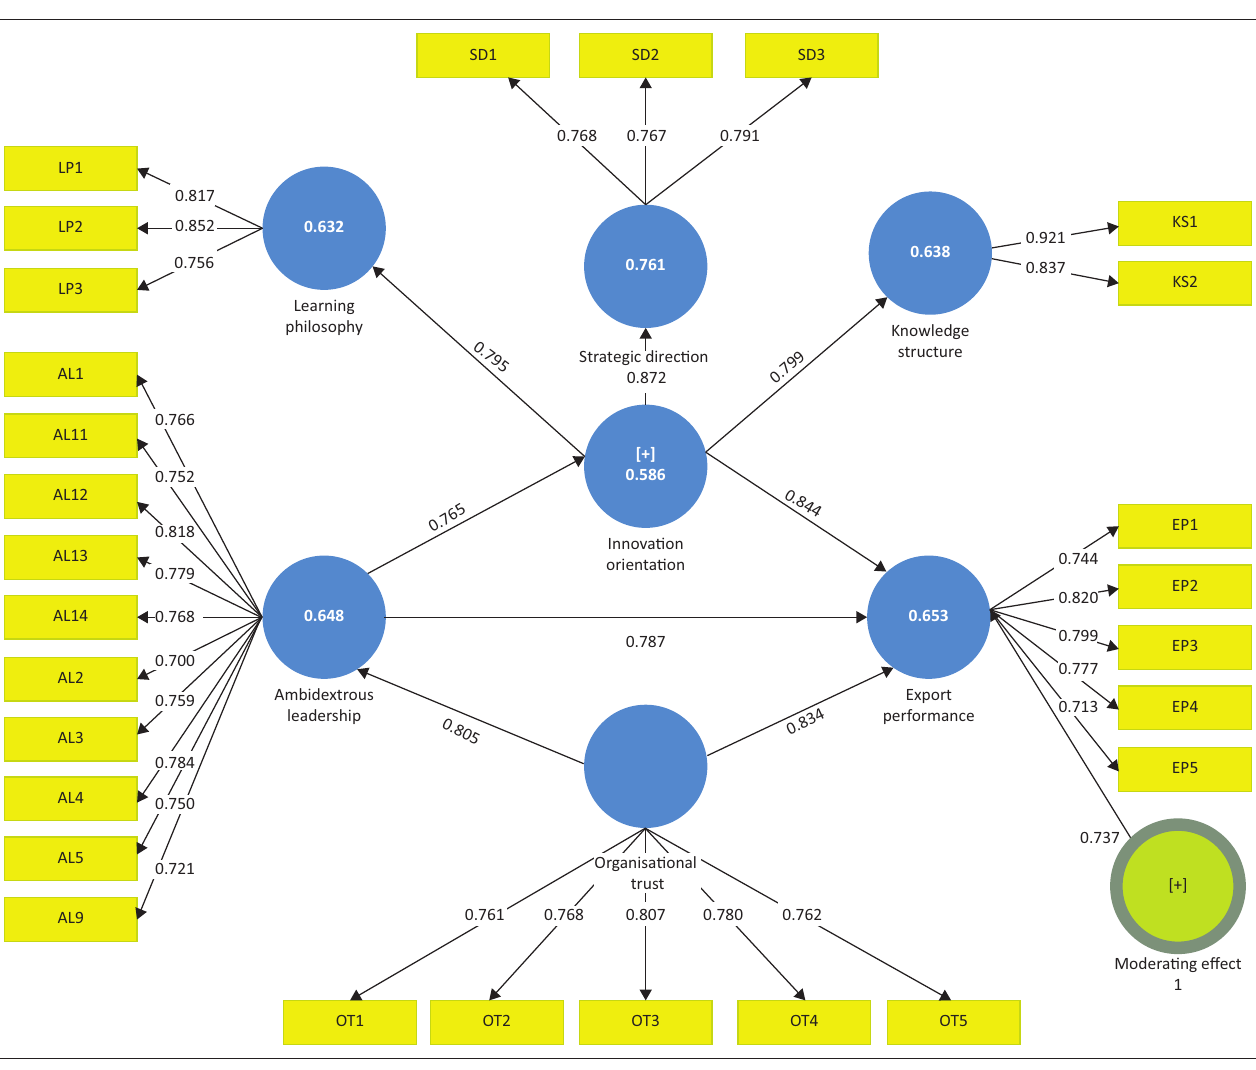
FIGURE 2: Structural path